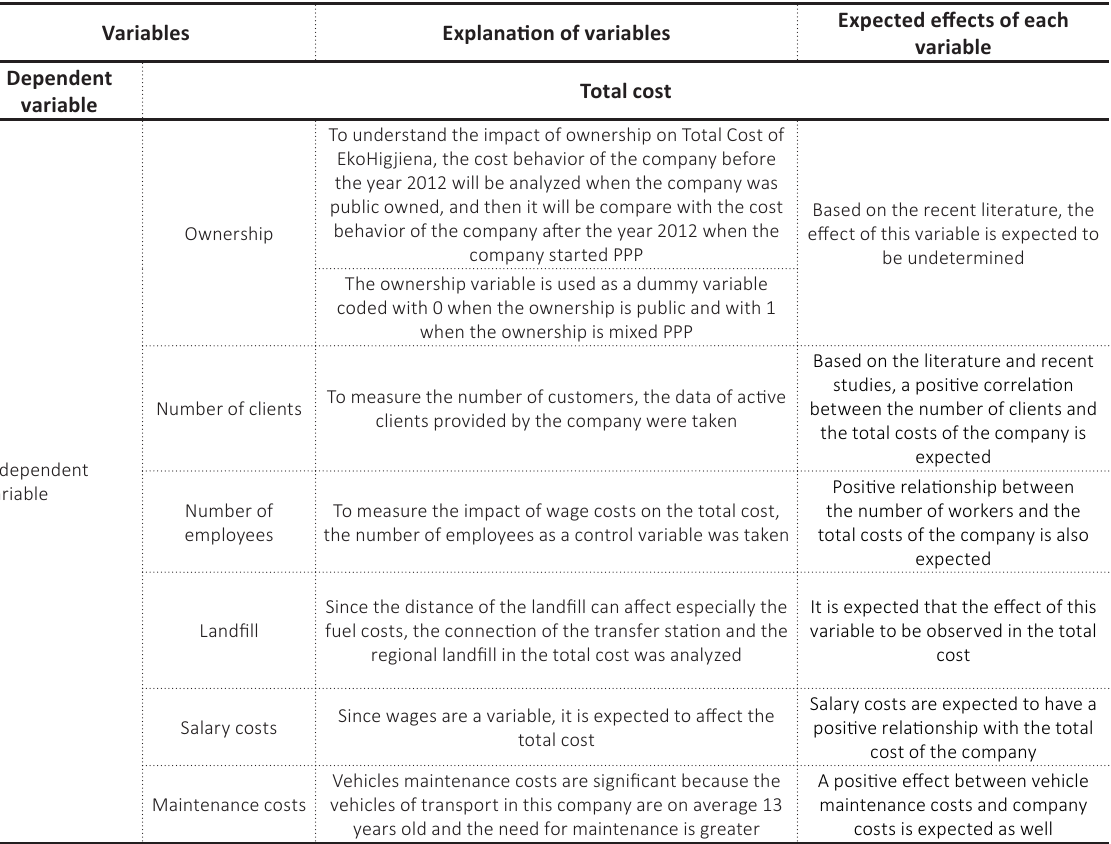
Source: Authors’ summary of